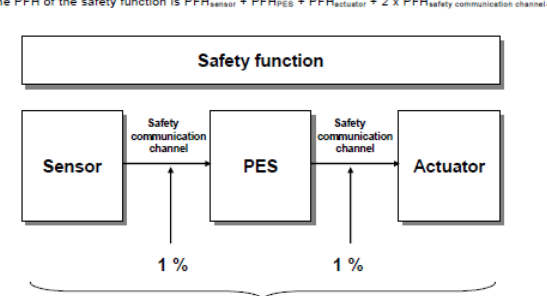
Fig. 4. Safety communication as a part of safety